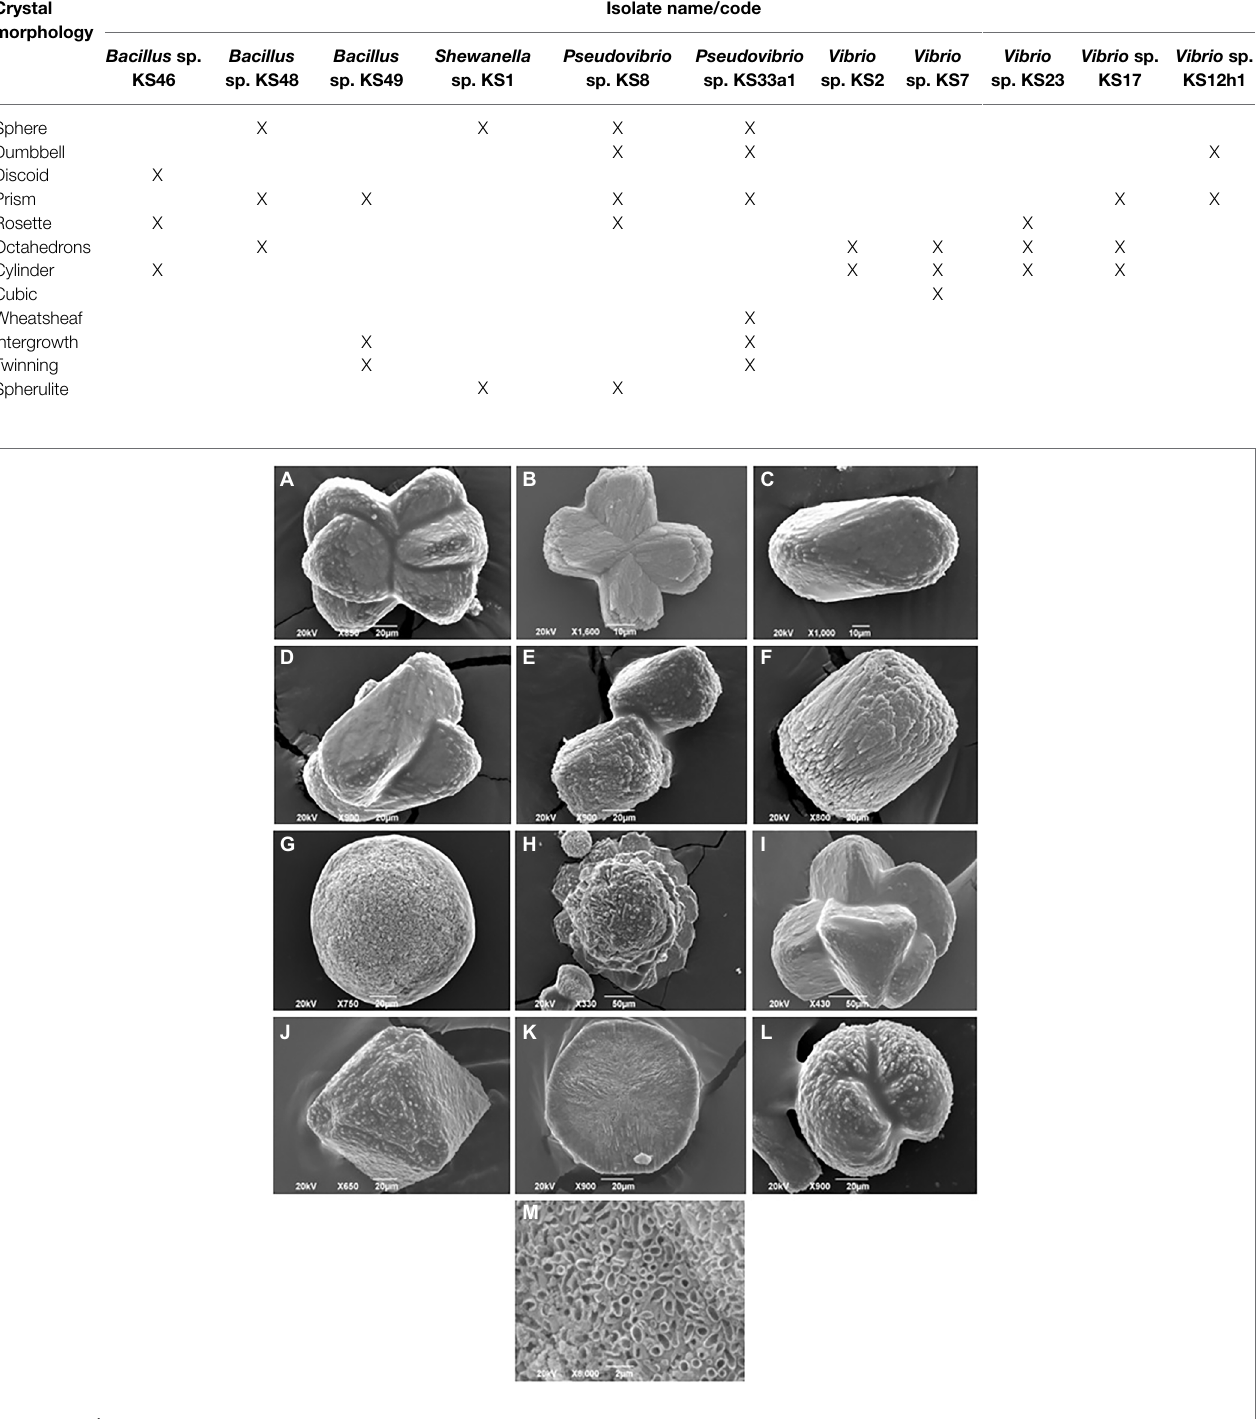
FIGURE 5 | Scanning electron images of different crystals morphology harvested from sponge cultured bacteria. (A) Wheatsheaf shape, (B) Dumbbell shape, (C) Prism shape, (D) Intergrowth, (E) Cubic shape, (F) Cylinder shape, (G) Sphere shape, (H) Rosette shape, (I) Twinning shape, (J) Octahedrons shape, (K) Discoid shape, (L) Spherulite shape, and (M) close up image of disc shaped crystal.